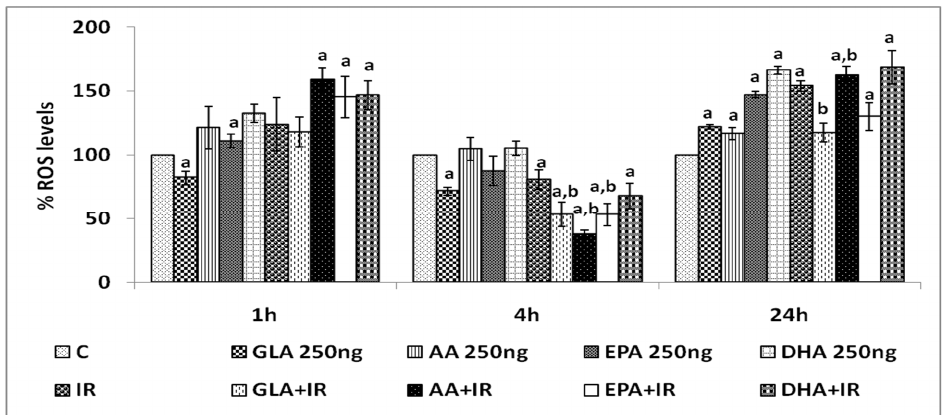
Table 2. Estimation of antioxidant status in RAW 264.7 cells. RAW 264.7 cells were pre-treated with 250 ng/mL GLA 24 h prior to irradiation at 2 Gy (at 1 Gy/min). Supernatant and cell lysate were obtained at 24 and 48 h post-radiation, and were used for the estimation of various antioxidants. Values (n = 6) expressed as mean ± SE. Statistical significance was determined by t -test ( p < 0.001). Significance expressed as a , b , and c significance with control, GLA, and IR of same time point, re- spectively. C, control; GLA, gamma-linolenic acid; IR, irradiation (2 Gy).